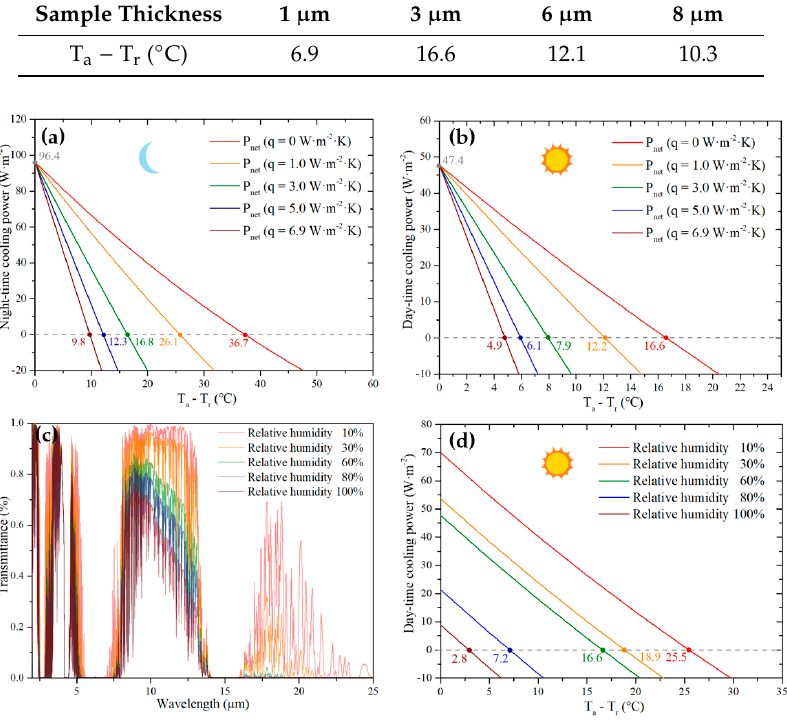
Figure 5. Theoretical ( a ) nighttime and ( b ) daytime net cooling power of the bilayer selective emitter with relative humidity 60%. ( c ) Atmospheric transmittivity with different relative humidity. ( d ) Daytime cooling performance of the emitter with different relative humidity.